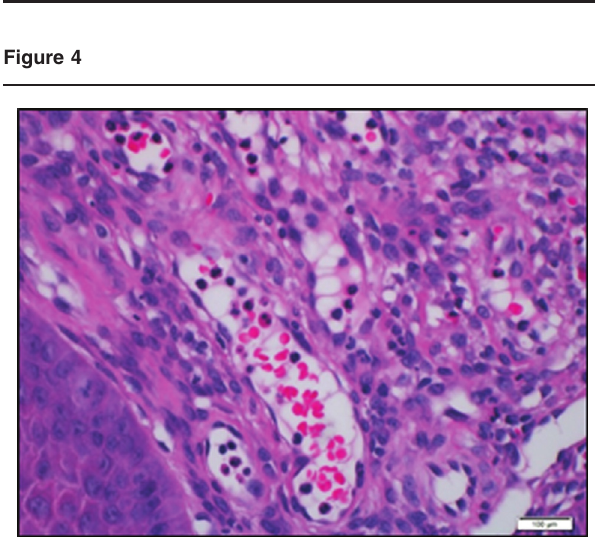
Tongue biopsy shows hyperplastic stratified squamous mucosa with underlying dense chronic inflammatory infiltrate with occasional lym- phoid aggregates (H&E, ×2).